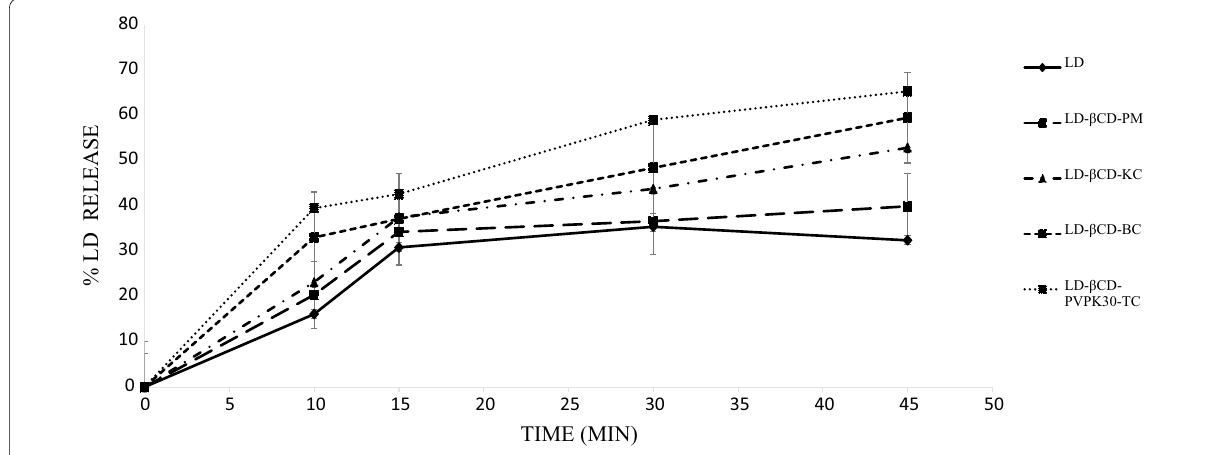
Fig. 6 The dissolution profiles of LD, PM’s, binary and ternary complexes